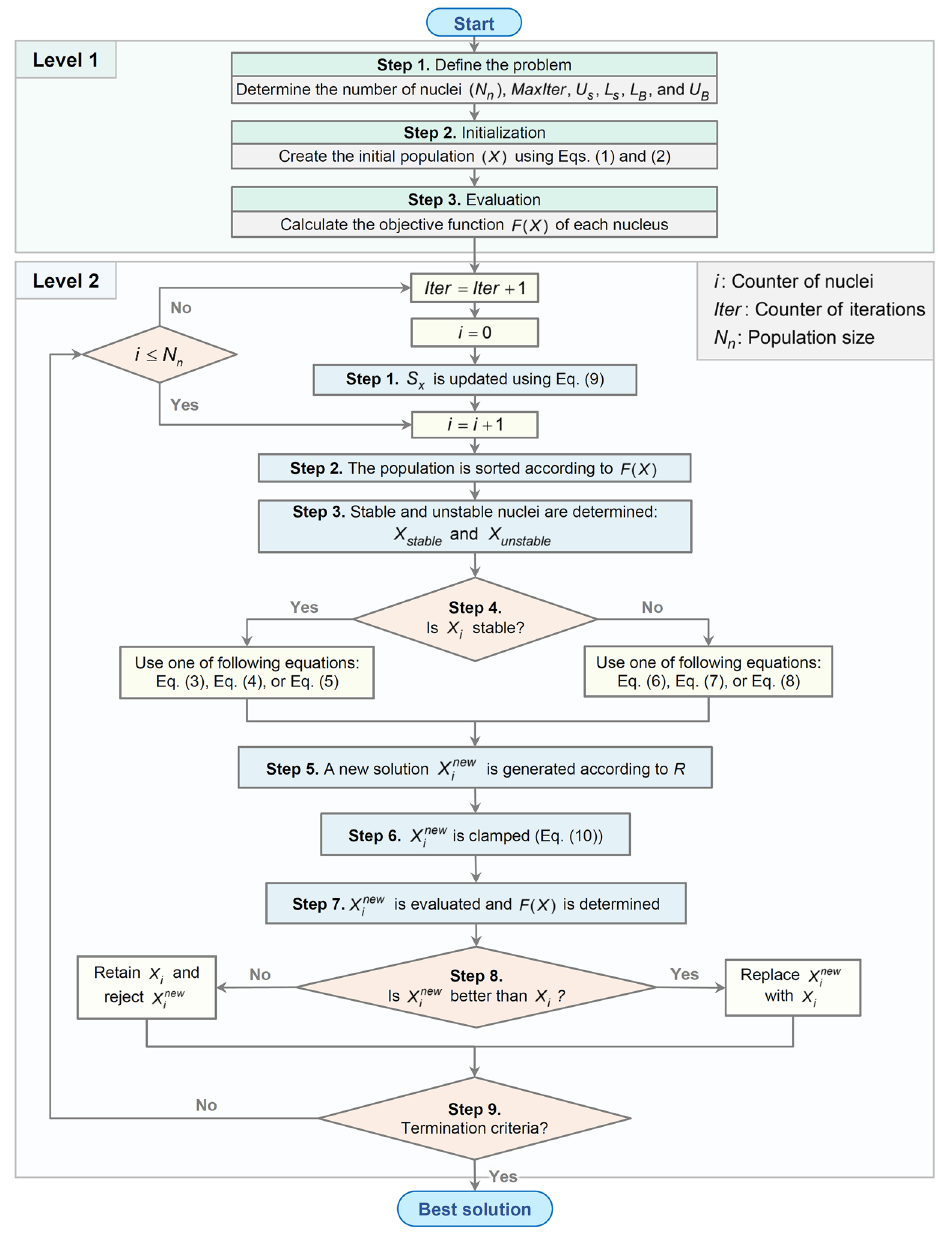
Figure 12. Flowchart of the Fusion–Fission Optimization (FuFiO)